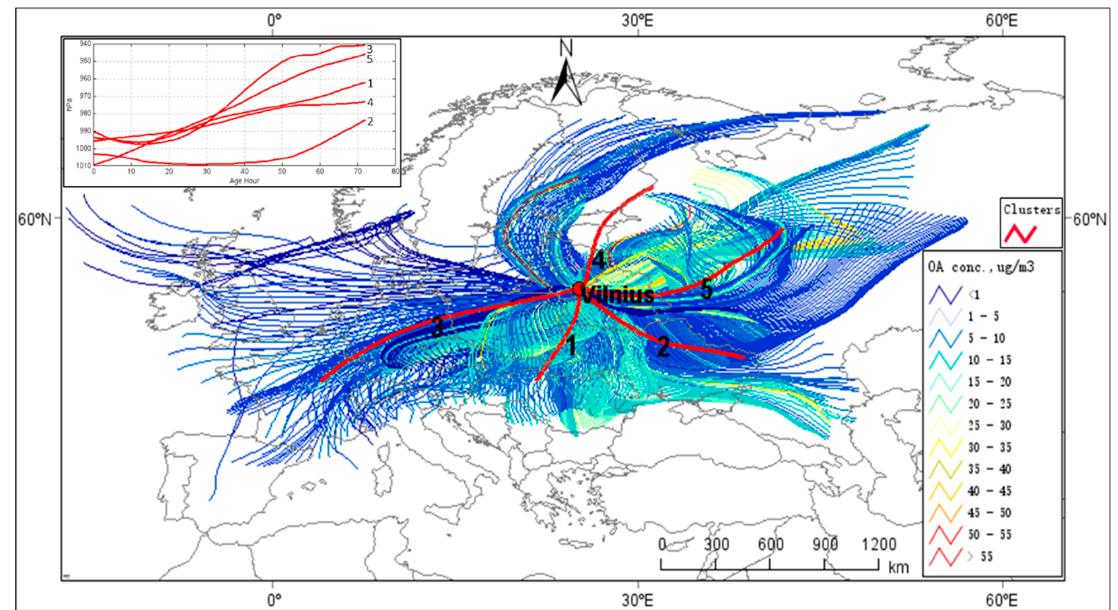
Figure 8. Air mass backward trajectories and clusters with associated OA concentration in January and February